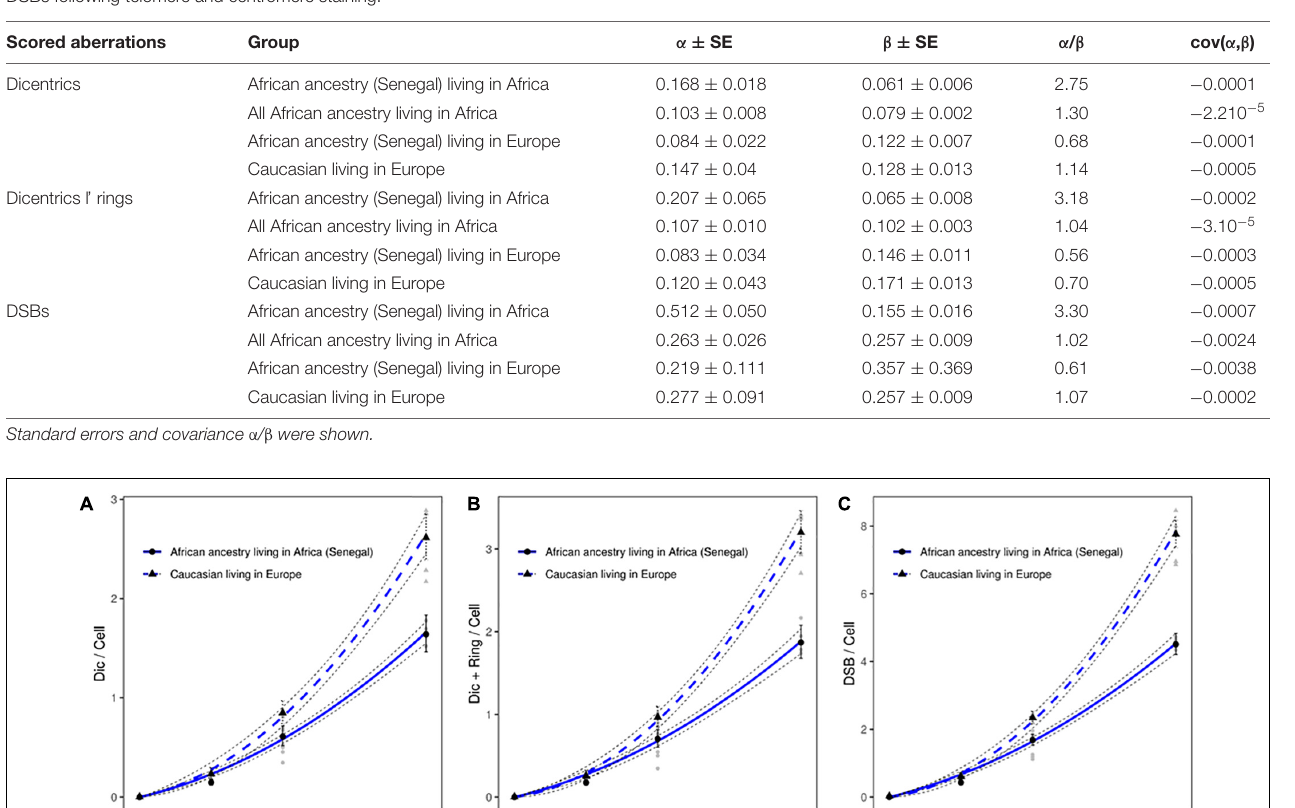
TABLE 1 | α and β coefficients for different groups after X-ray exposure and scoring of dicentric chromosomes, dicentric and ring chromosomes, and the calculated DSBs following telomere and centromere staining. Scored aberrations